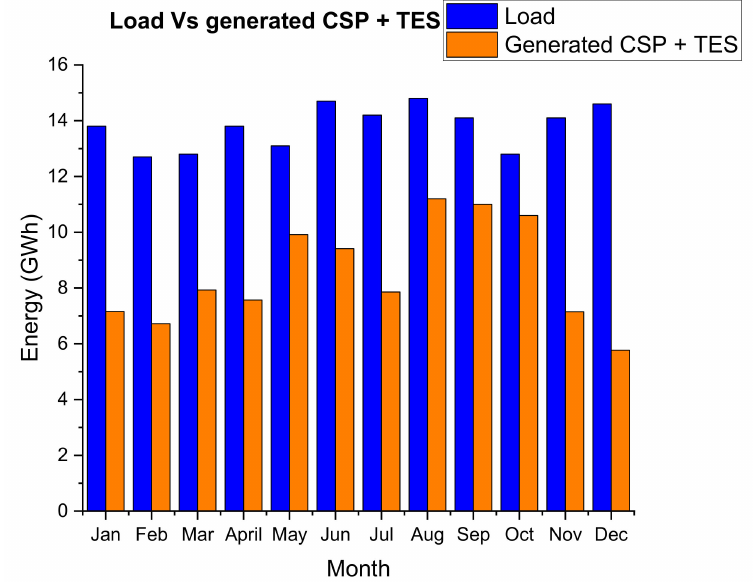
Figure 27. Monthly generated energy from CSP and TES vs. monthly